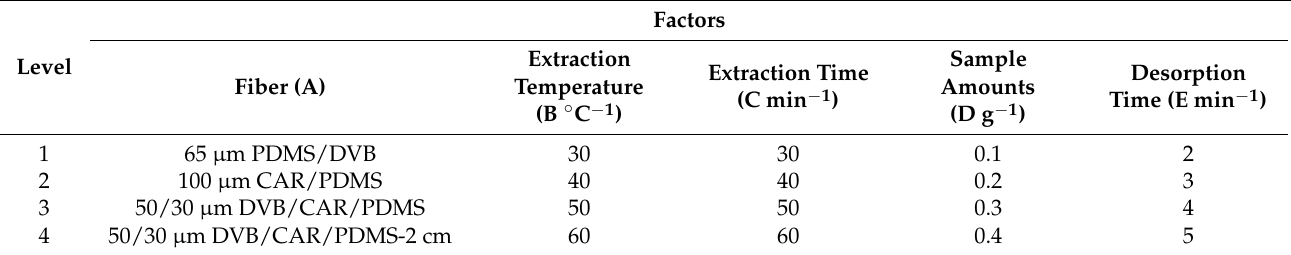
Table 1. Optimization of HS-SPME parameters with L 16 (4 5 ) orthogonal